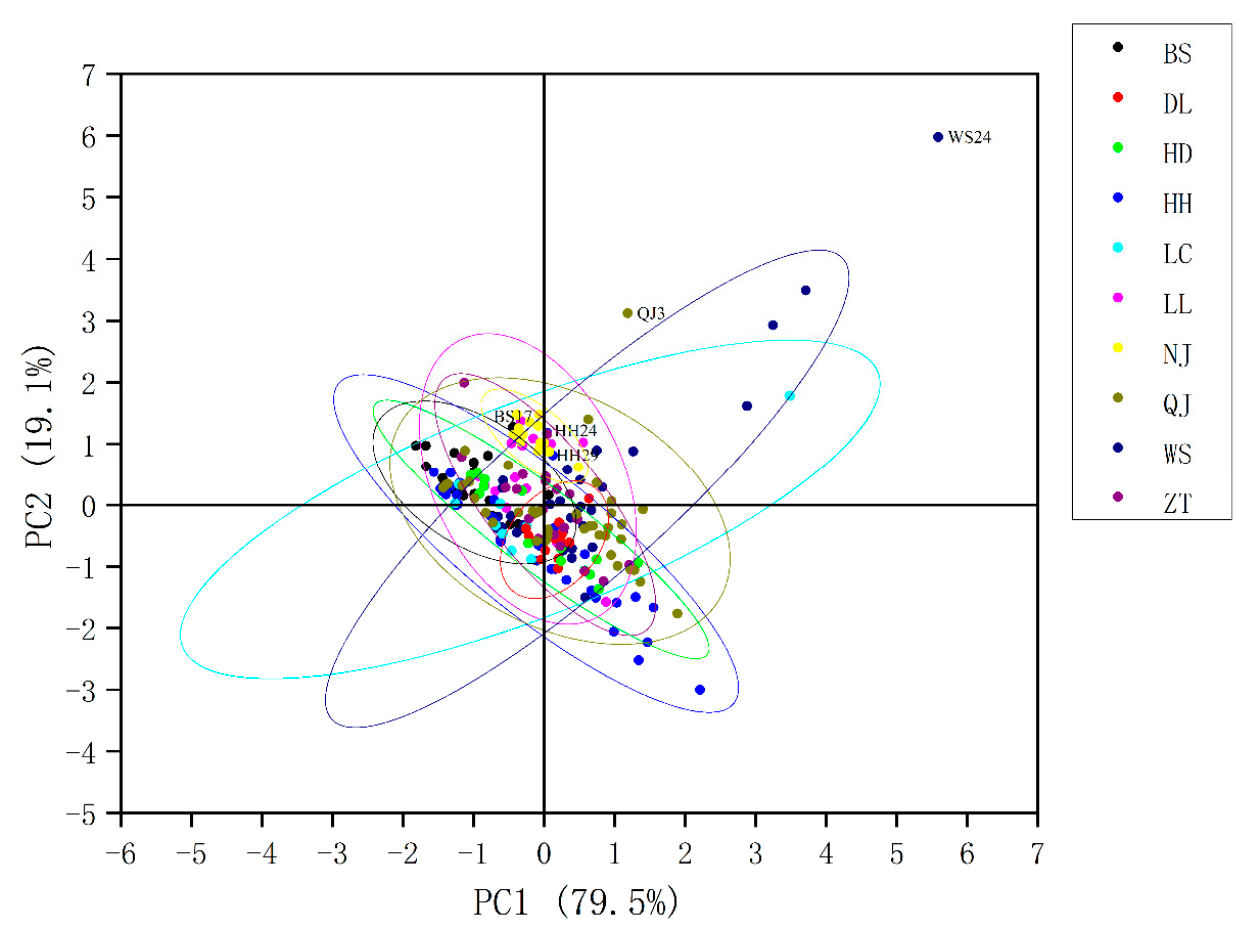
Figure 2. PCA analysis of FT-NIR.